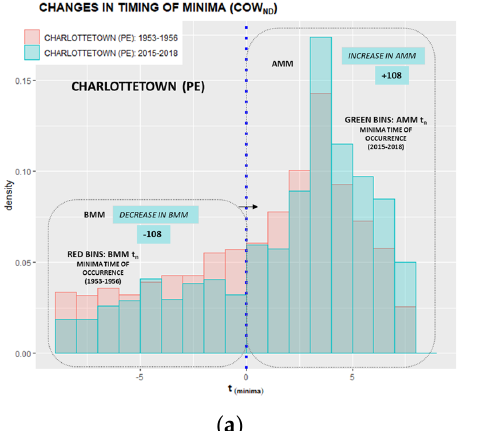
Figure A18. Cont